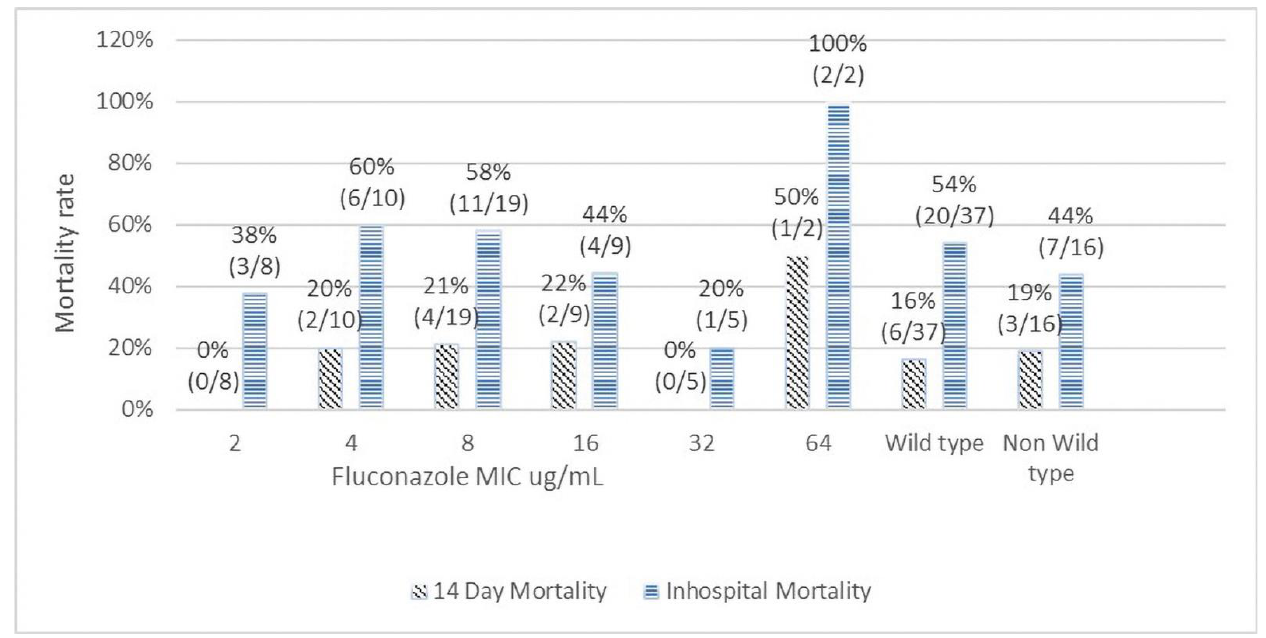
Figure 1. Correlation of amphotericin B minimal inhibitory concentration (MIC) with 14-day and in-hospital mortality.